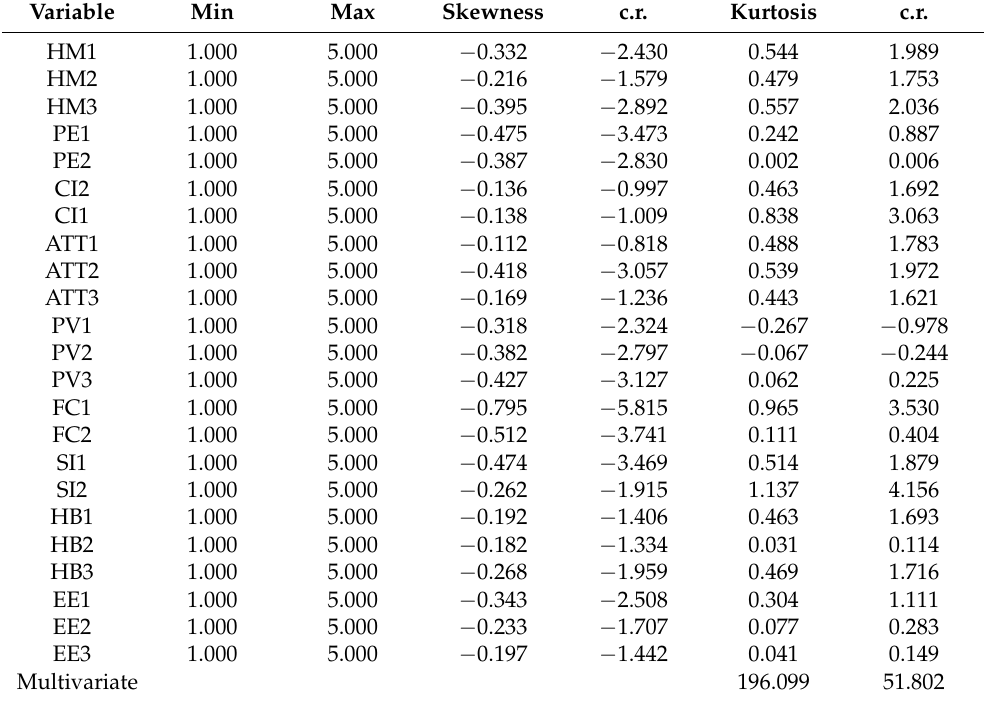
Table 2. Normality testing and descriptive